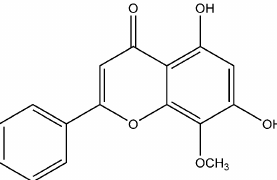
Figure 3. Chemical structure of 4′-hydroxy-6,7-methylenedioxy-3-methoxyflavone.